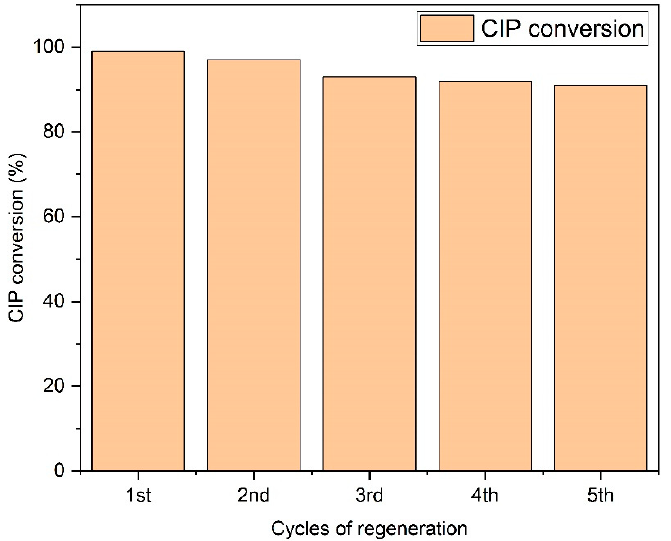
Figure 15. CIP conversion after five cycles of regeneration (catalyst: CuFe 2 O 4 -70%/rGO/HNT; reaction time: 5